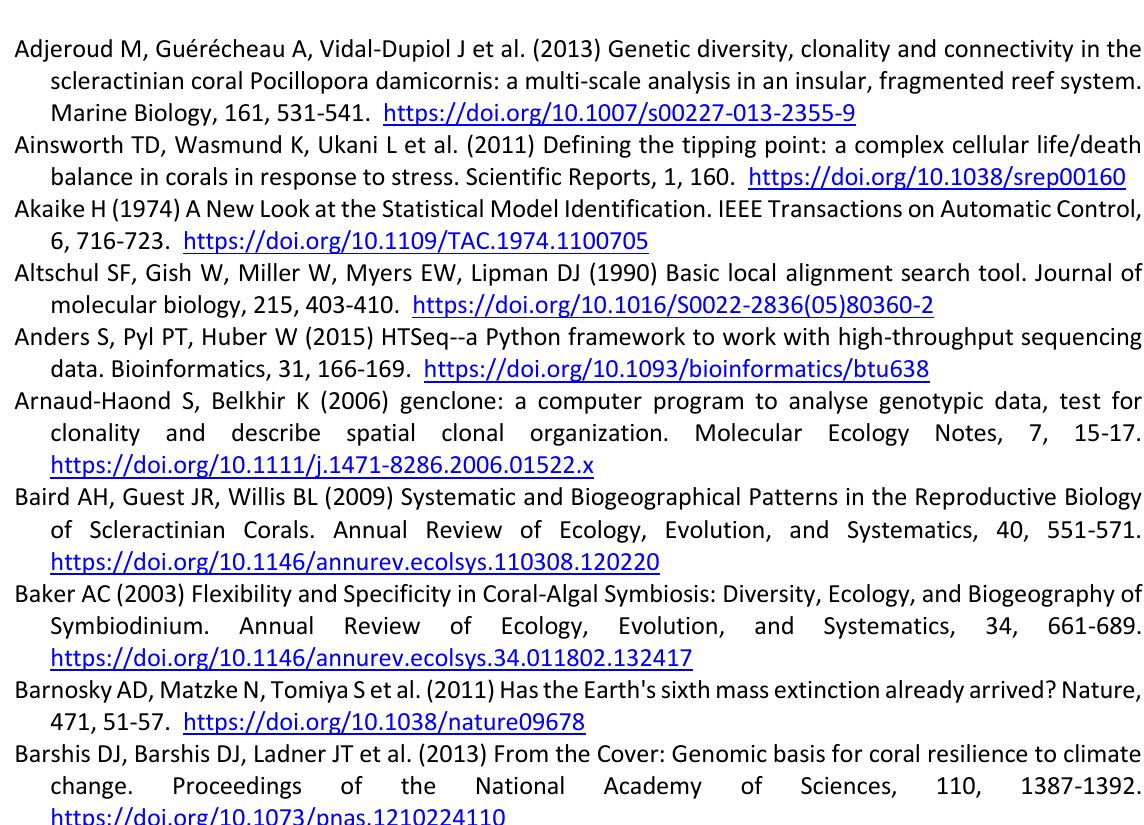
colonies, or experimental